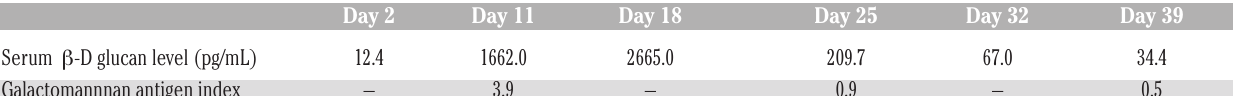
Table 1. Transition of serum β -D glucan level and aspergillus galactomannan antigen index. Normal values: β -D glucan < 20 pg/mL, galactomannan antigen index < 0.5.